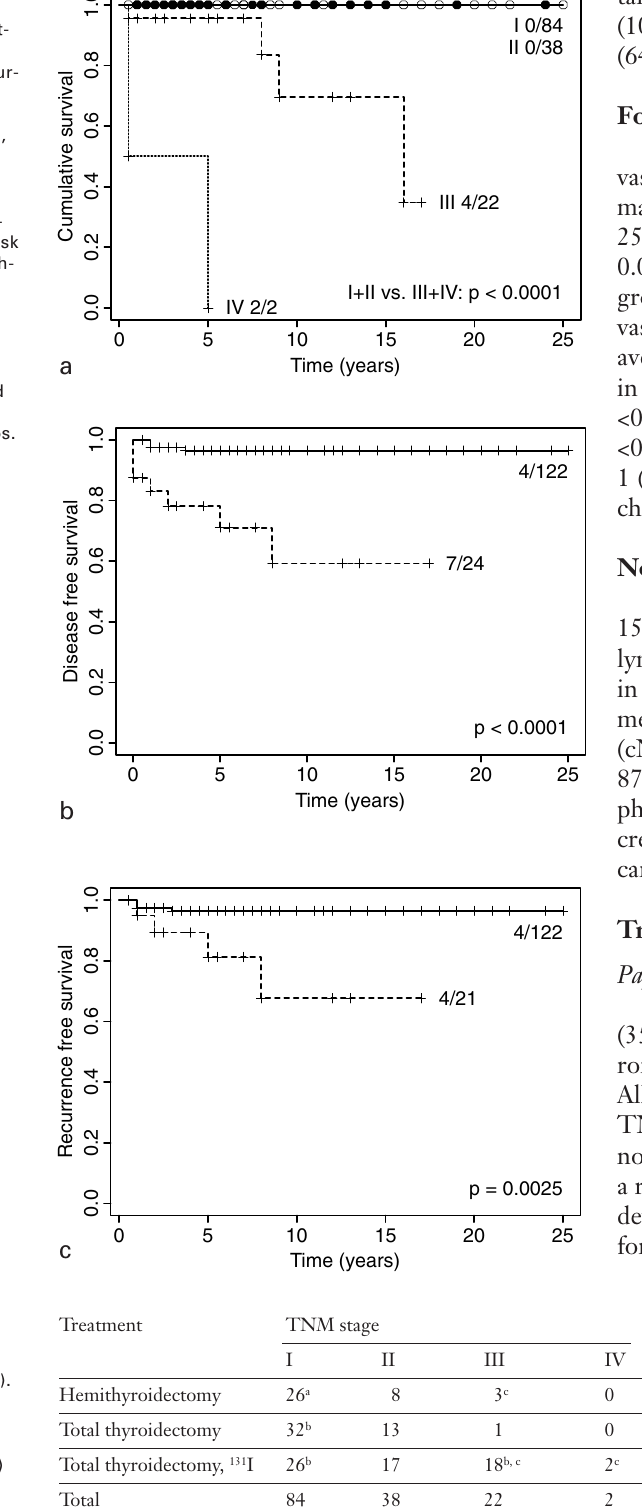
Late results of treat- ment of PTC. a. Cause-specific sur- vival in stages I-IV (I: solid line, open circles; II: solid line, closed circles; III: broken line, +; IV: dotted line, +). b. Disease-free sur- vival in TNM low-risk (solid line) and high- risk (broken line) groups. c. Recurrence-free survival of patients treated for cure in TNM low-risk